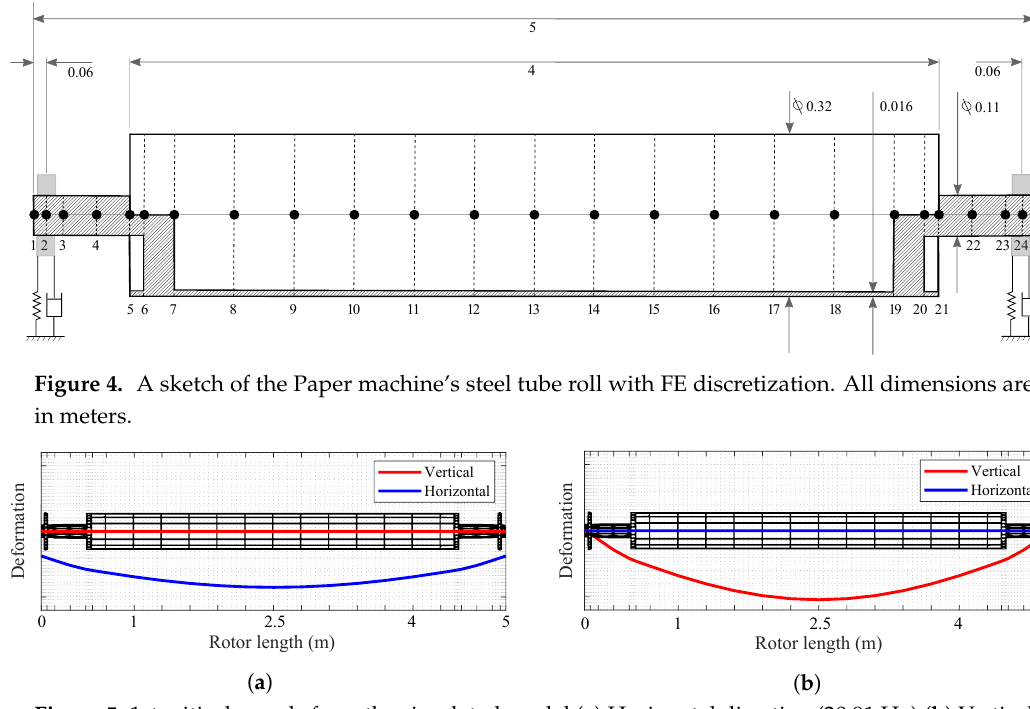
Figure 5. 1st critical speeds from the simulated model ( a ) Horizontal direction (20.91 Hz) ( b ) Vertical direction (29.31